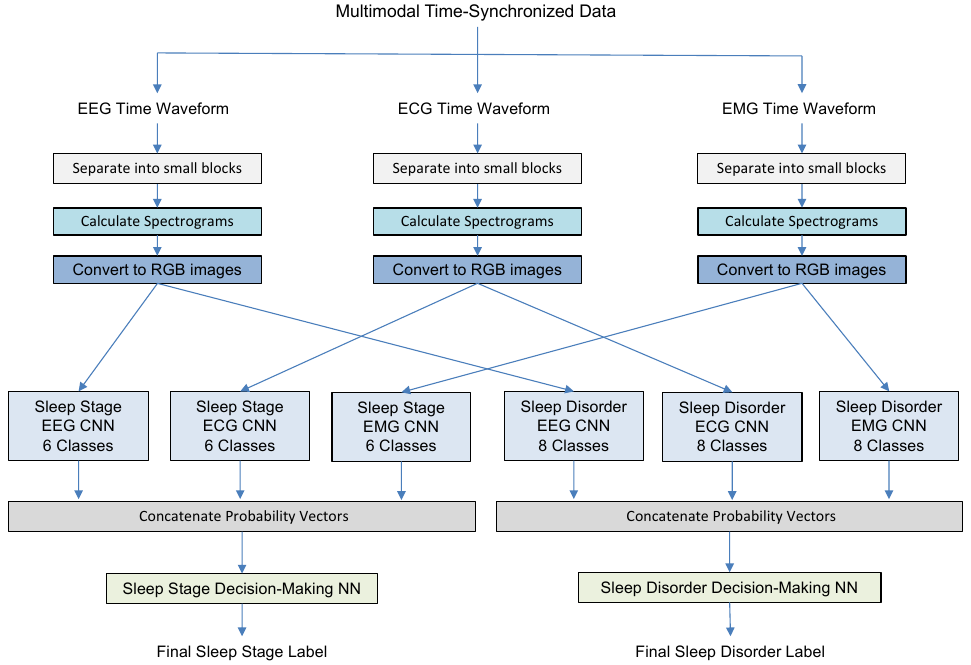
Figure 2. Experiment 2: Sleep stage and sleep disorder classification using MML-DMS1.